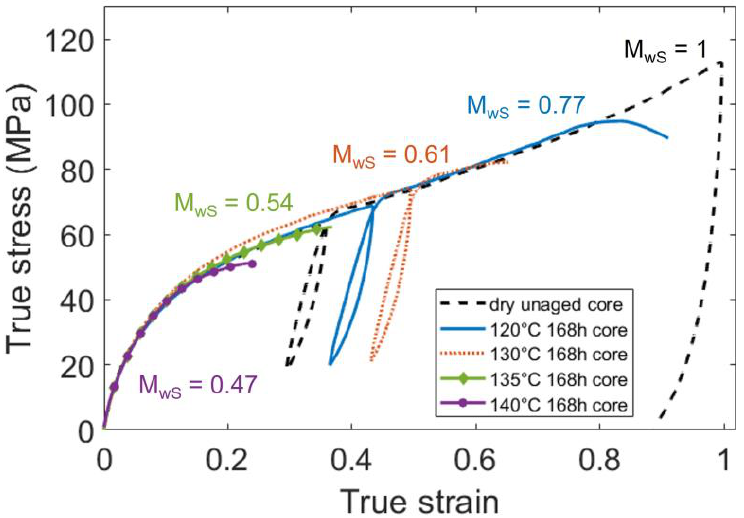
Figure 16. Strain-stress curves of PA66 aged during 168 h, and a dry unaged PA66. Specimens taken at the core of the plaques.